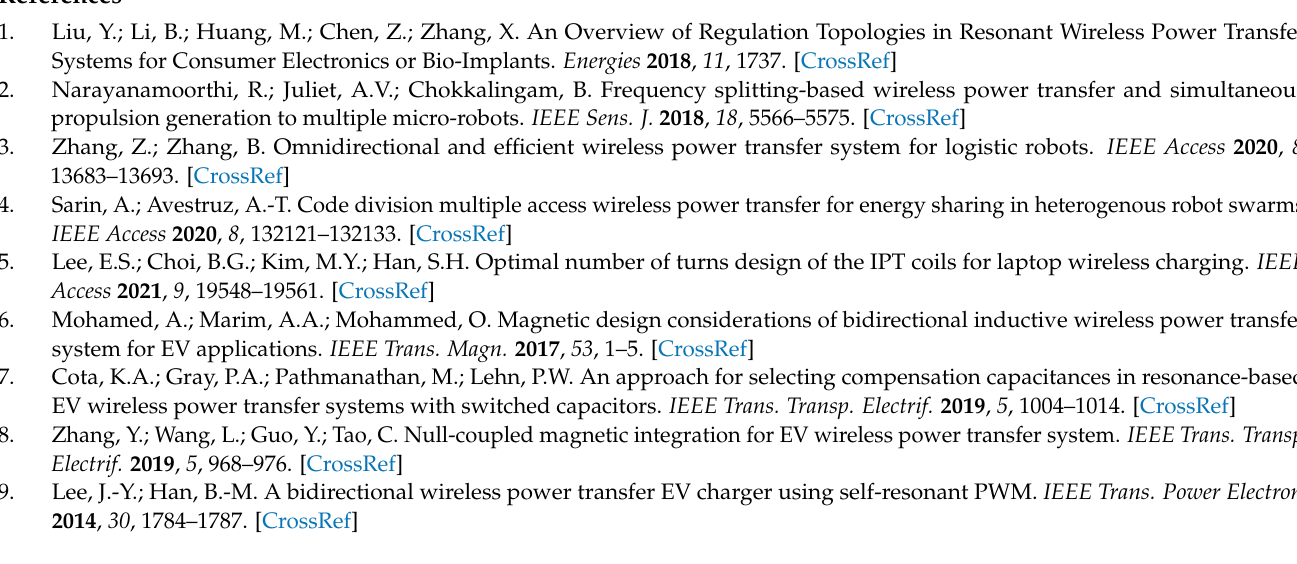
Figure A3. Reactive power at the optimal resonance setting for S-M WPT systems according to the air gap of 10 mm and 30 mm. ( a ) Air gap of 10 mm; ( b ) Air gap of 30 mm.